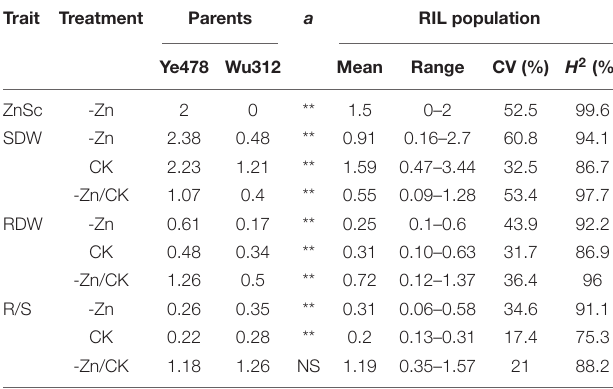
TABLE 1 | Statistical analysis of phenotypic variation of parents and their RIL